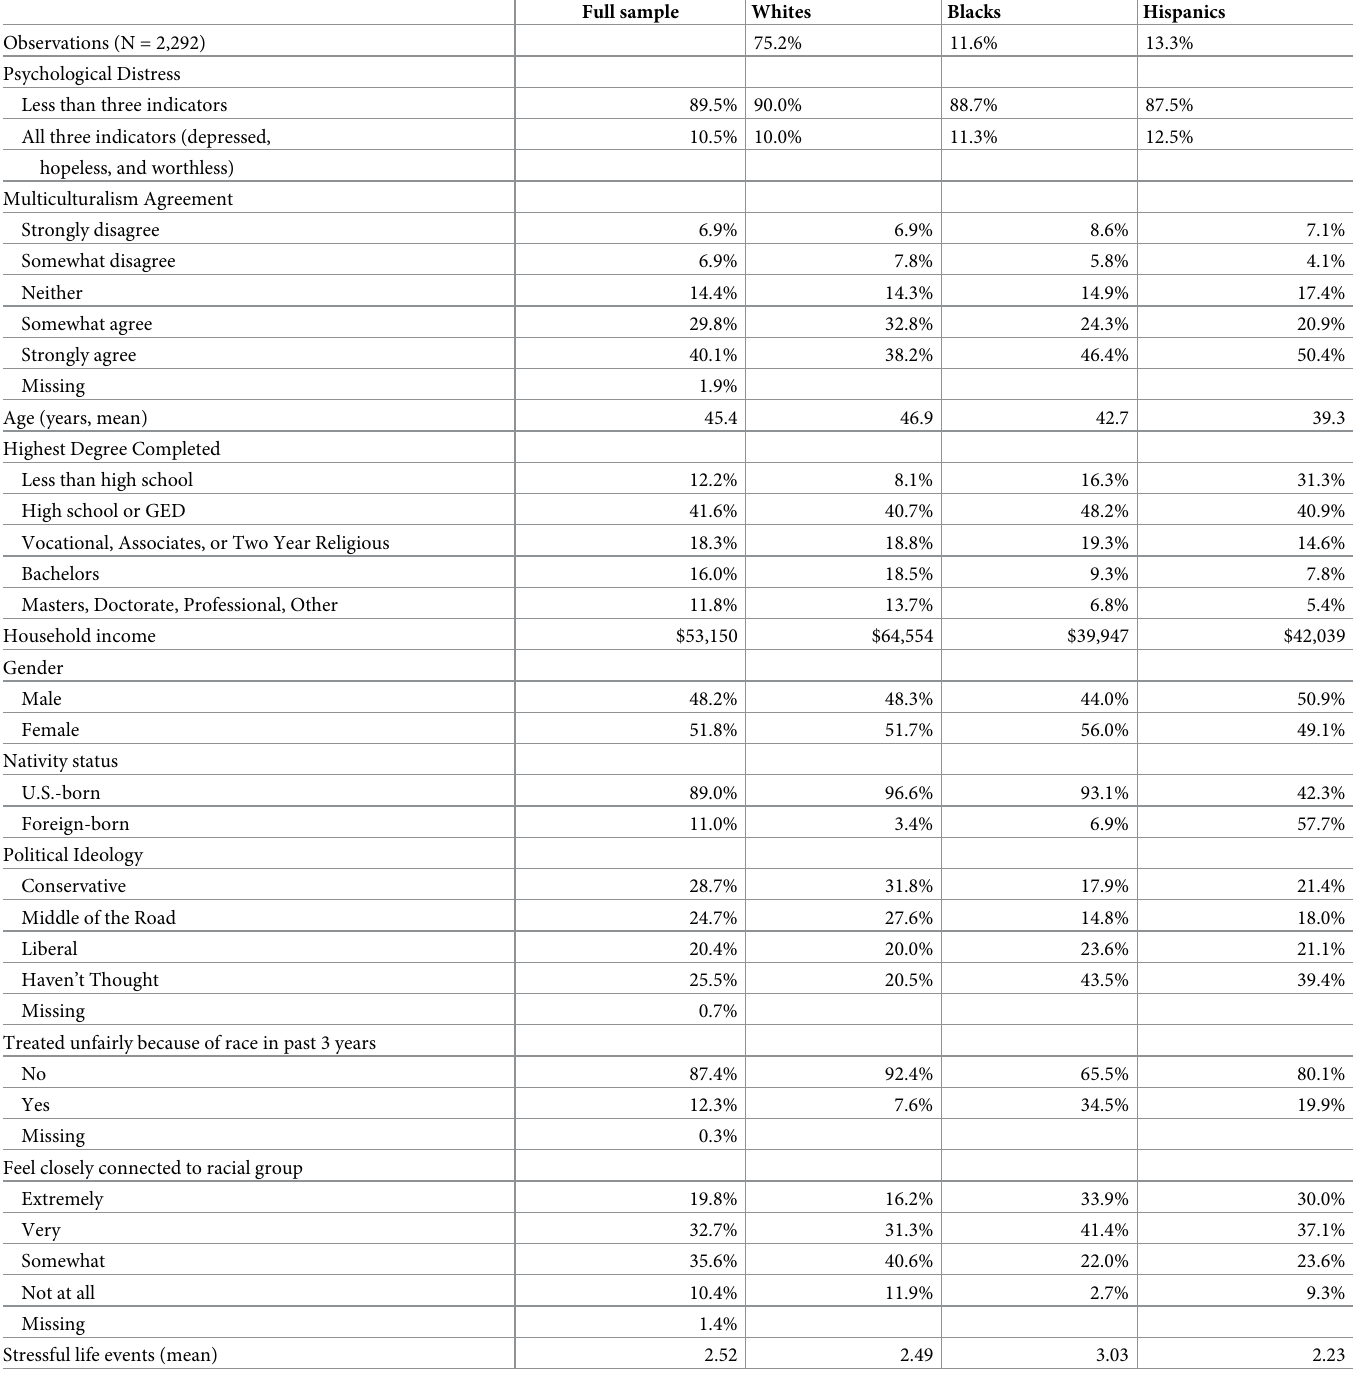
Table 1. Sample distributions of variables by race